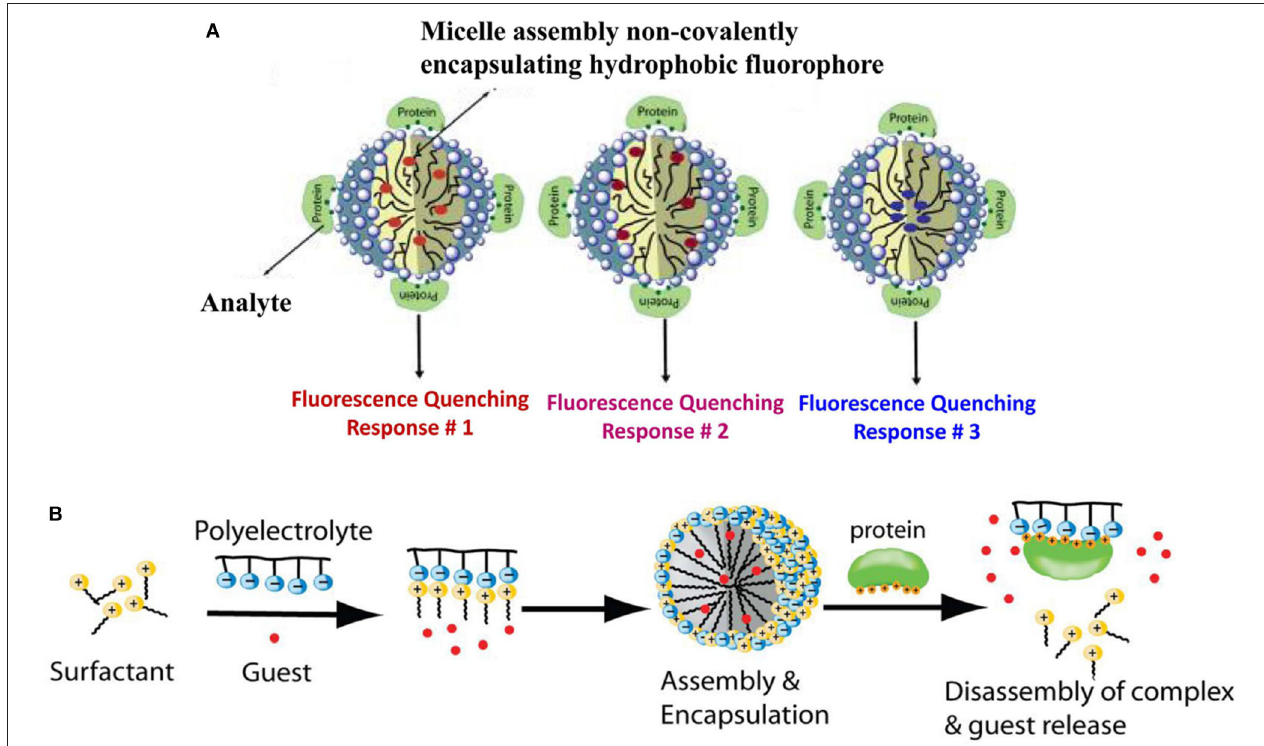
FIGURE 2 | Schematic representation for protein recognition: (A) A single amphiphilic polymer encapsulated different dyes and (B) A surfactant-polyelectrolyte ensemble encapsulated different dyes. Reprinted from Sandanaraj et al. (2007) and Gonzalez et al. (2009) with permission.